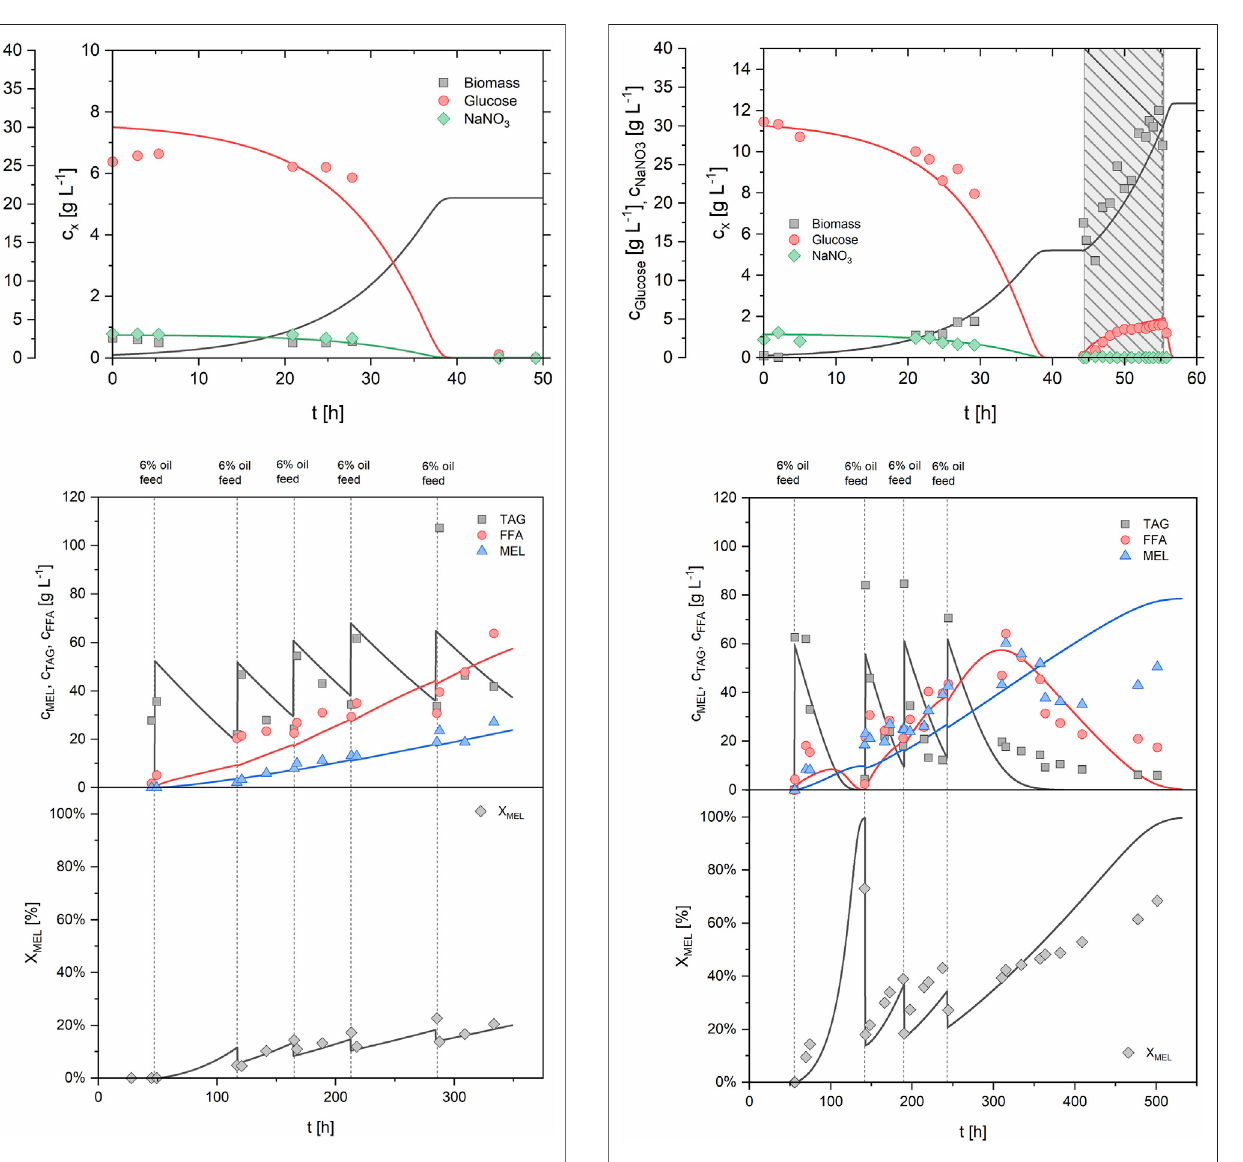
FIGURE8| Comparison ofsimulatedandexperimentaldataforprocess FB1 using the parameters from Table 4 . Batch and fed-batch growth phase (upper, feeding phase is highlighted) and production phase with repeated oil feeding (lower) are